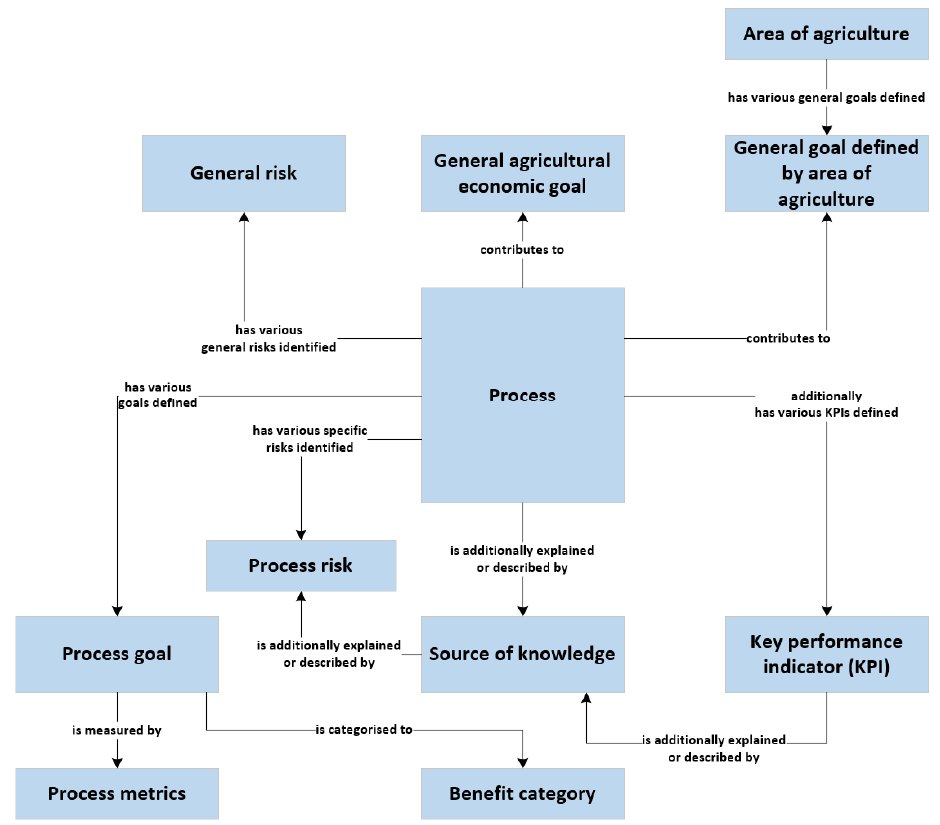
Figure 2. Process risks, contribution and efficiency conceptual sub-model.